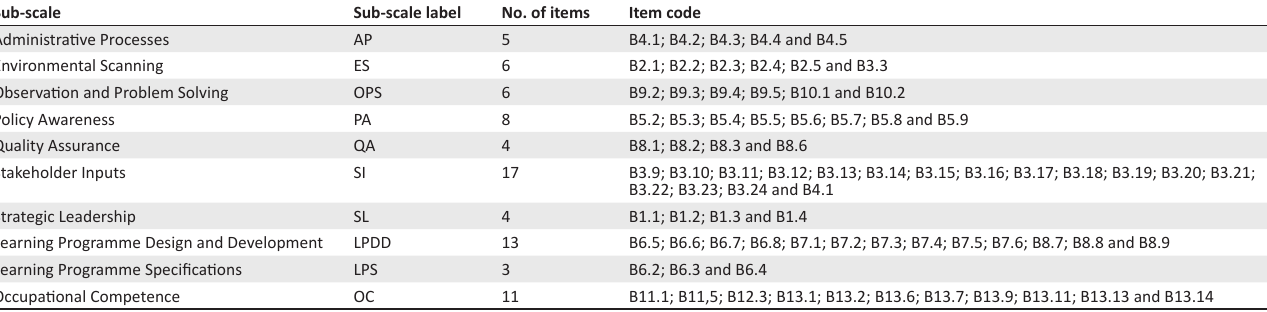
TABLE 4: Summary of the final sub-scales and items of the learning programme management and evaluation scale. Sub-scale